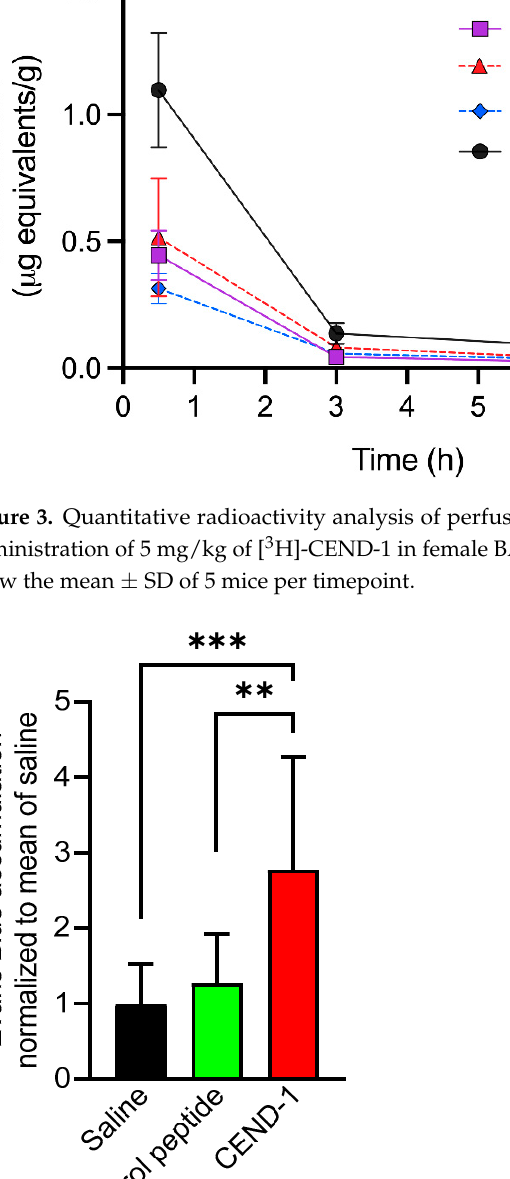
Figure 3. Quantitative radioactivity analysis of perfused tissues at 0.5–8 h following intravenous administration of 5 mg/kg of [ 3 H]-CEND-1 in female BALB/c mice with 4T1 cell tumours. The data show the mean ± SD of 5 mice per timepoint.